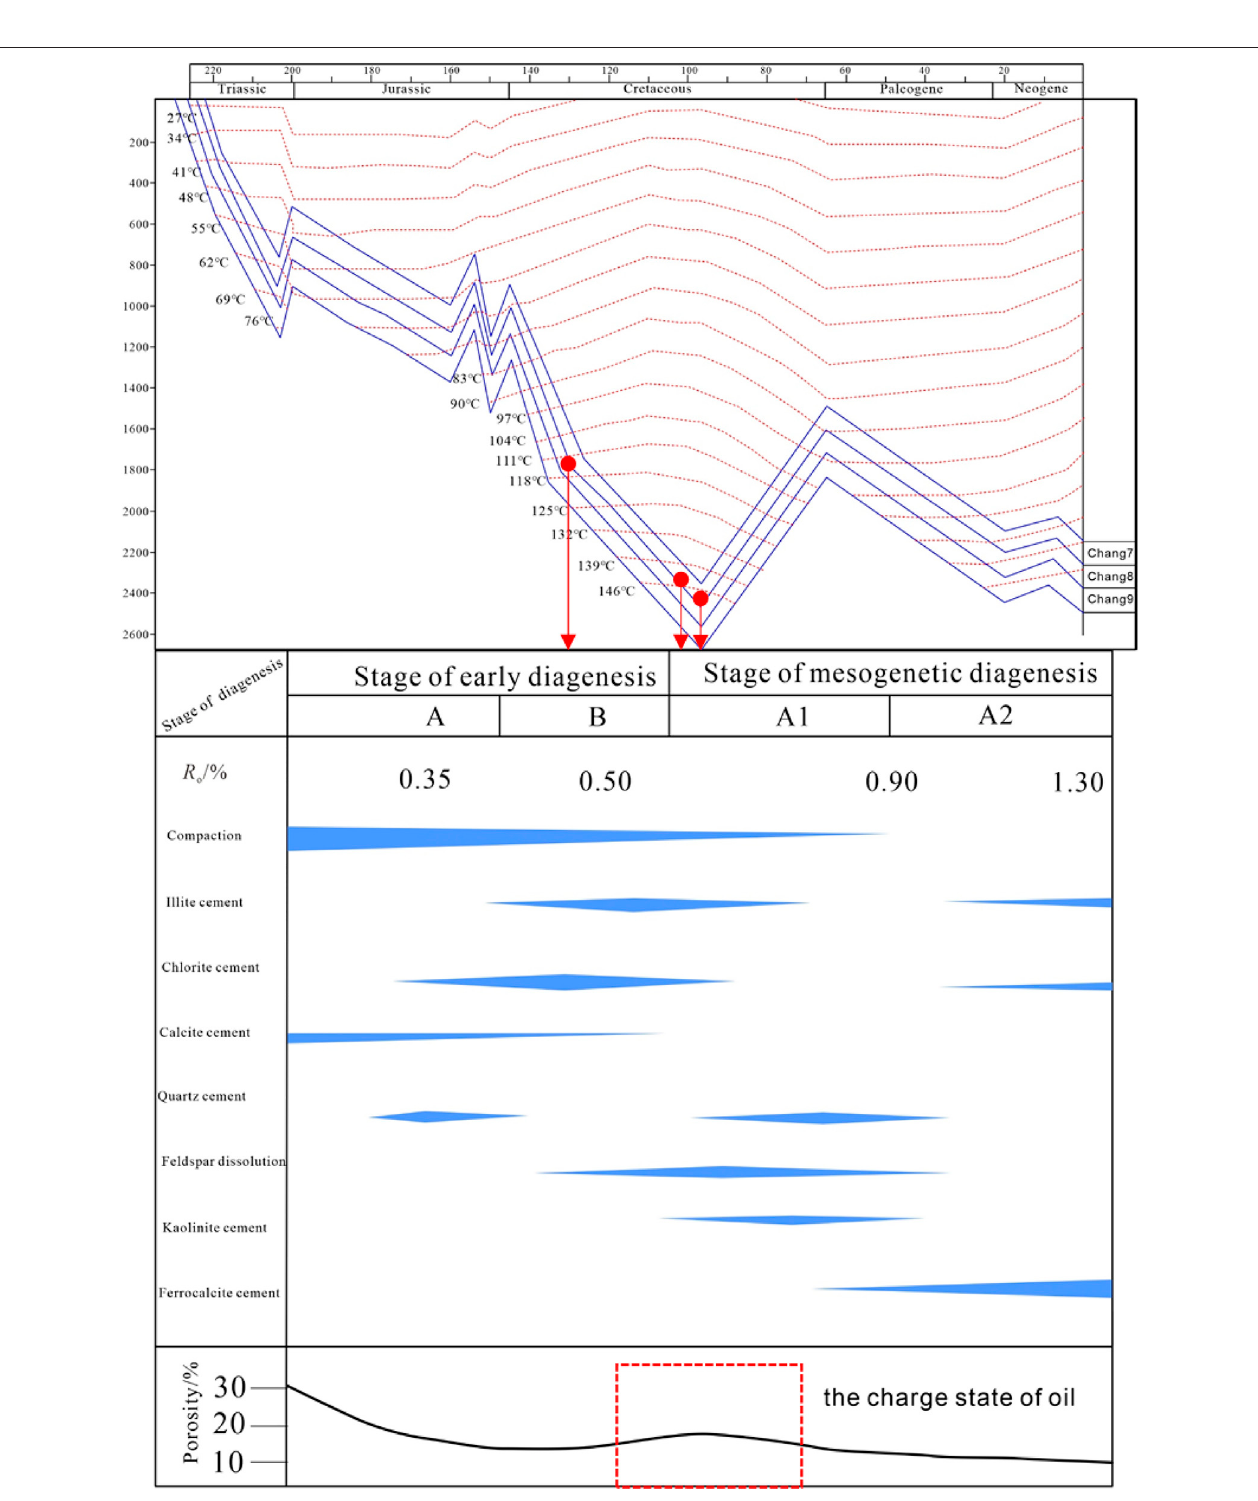
FIGURE 6 | Burial-thermal history, diagenetic sequences, and the evolution of pores in the FGSR reservoir.